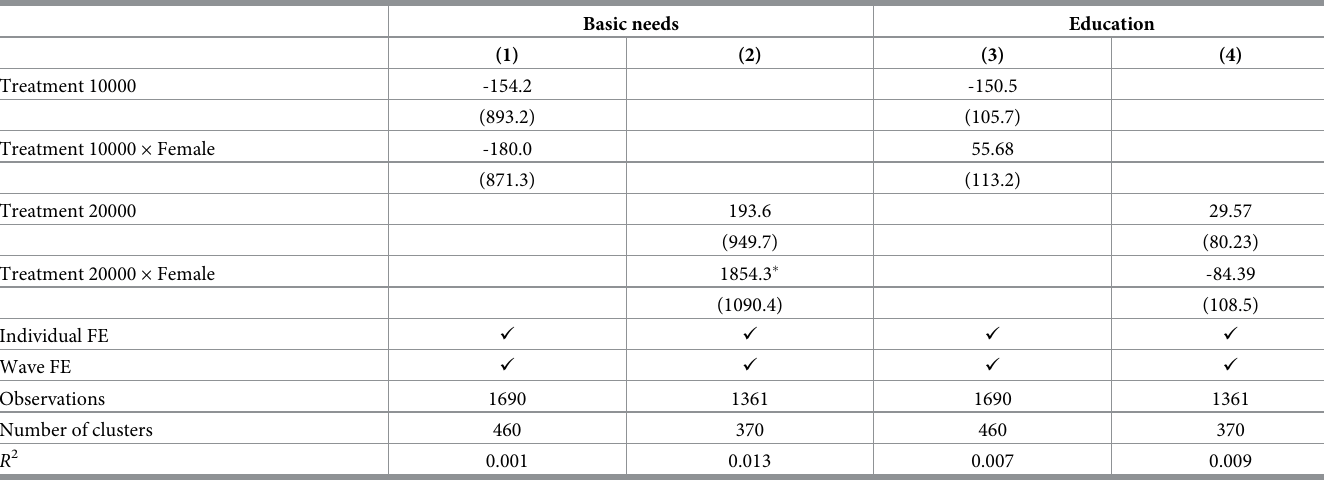
Table 8. Gender differences in household